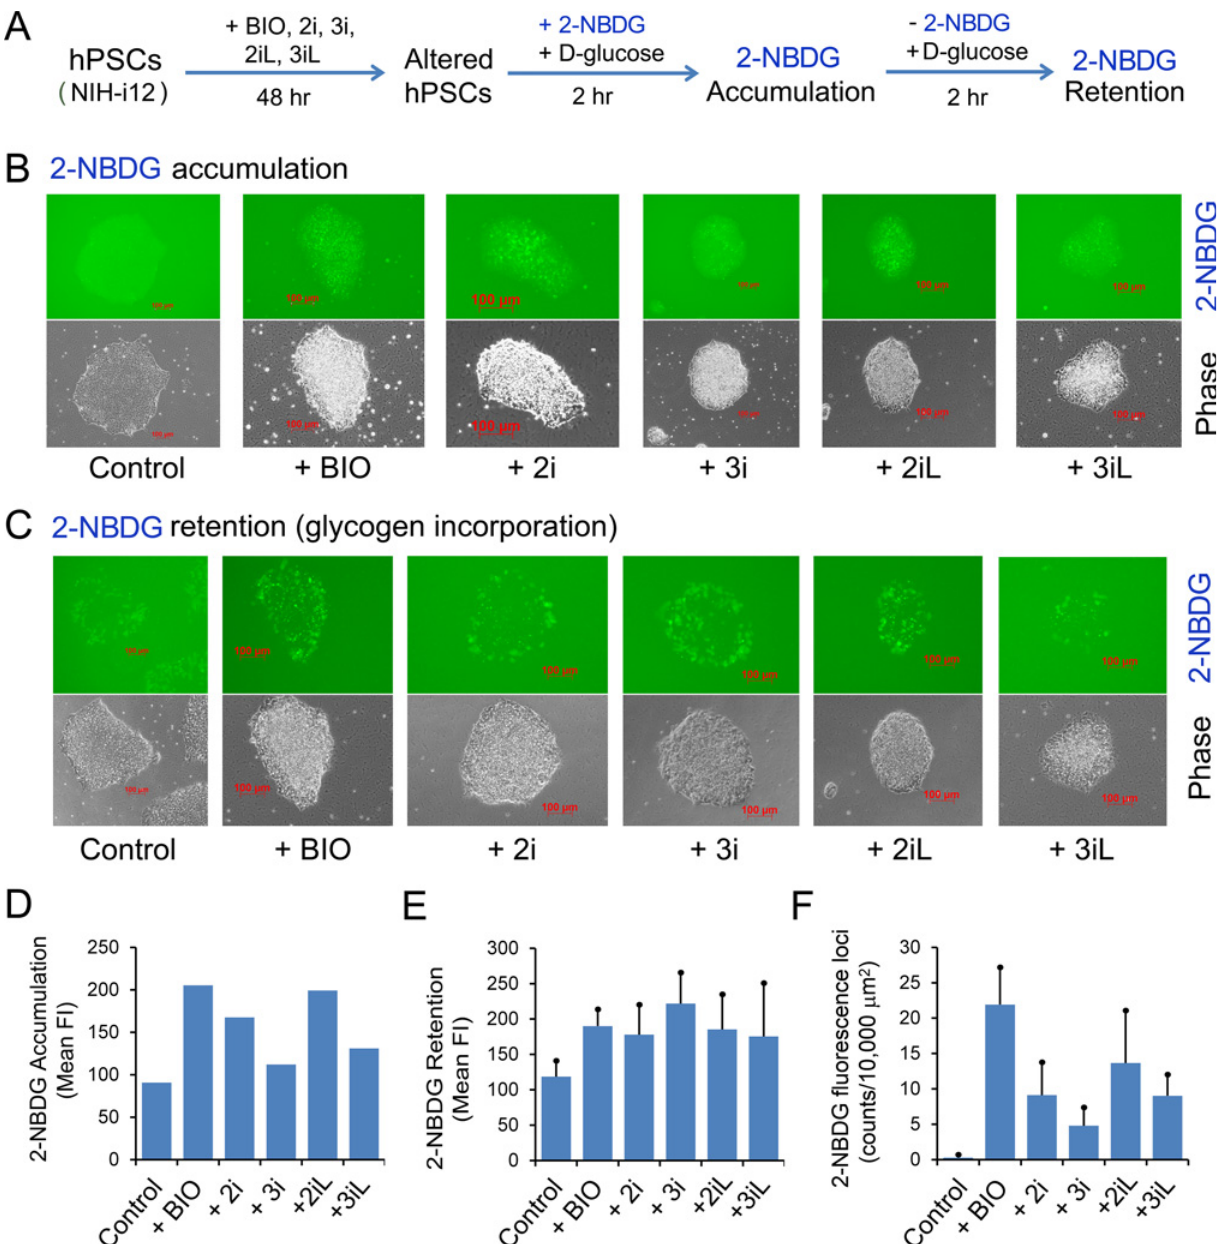
Fig 6. 2-NBDG accumulation and retention in NIH-i12 iPSCs under na ï ve hPSC growth conditions. ( A ) Schema of 2-NBDG accumulation and retention (glycogen labeling) experiments. ( B ) 2-hour 2-NBDG accumulation in the presence of 10 mM D-glucose. Upper panel: green fluorescence intensity (Fluor) images from 2-NBDG alone. These images were obtained (immediately after replacing with fresh mTeSR1 medium) by non-saturated time-exposure guided by an autoexposure software (Zeiss Inc.). Lower panel: the corresponding phase images of the upper panel. Only brightness was adjusted in phase images (presented in both B and C) to enhance the image presentation in this figure. ( C ) 2-NBDG retention and glycogen labeling carried out in the presence of 10 mM D-glucose and absence of 2-NBDG. Upper panel: unique fluorescence loci (dots) were derived from 2-NBDG signals as detailed in Fig 5. ( D ) Quantitative analysis of mean fluorescence intensity (FI) in Fig 6B. ( E , F ) Quantitative analysis of 2-NBDG retention and glycogen labeling by measuring mean fluorescence intensity (FI, arbitrary units) from at least 4 random colonies (E) and by counting 2-NBDG loci (F). Columns represent mean fluorescence intensity measured from at least 4 random colonies and bar standard deviations. Scale bars represent 100 μ